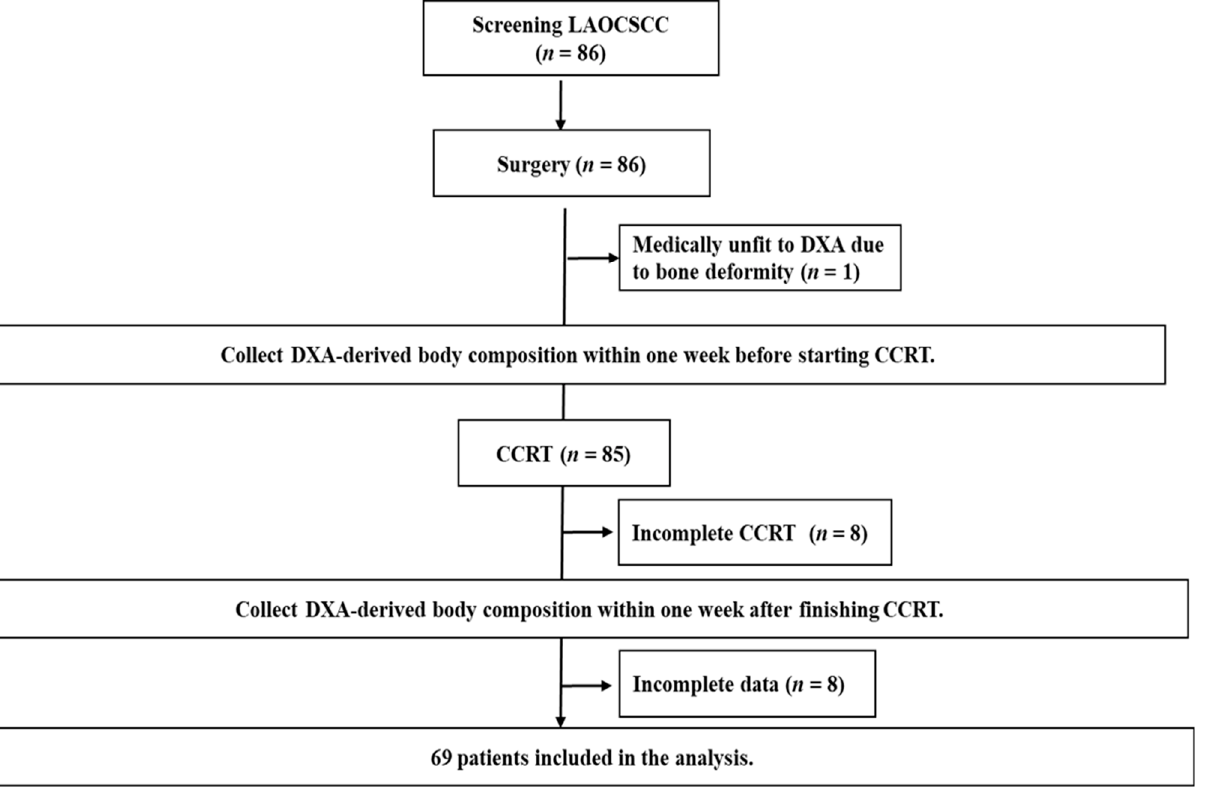
Figure 1. CONSORT diagram. CCRT was considered incomplete when patients dropped out during the treatment or failed to receive at least 4 cycles of weekly cisplatin (40 mg/m 2 ) concomitant with planned radiotherapy (64–72 Gy). Incomplete data indicates that patients did not complete the required DXA examinations or missed the scheduled blood tests. LAOCSCC, locally advanced oral cavity squamous cell carcinoma; DXA, dual-energy X-ray absorptiometry; CCRT, concurrent